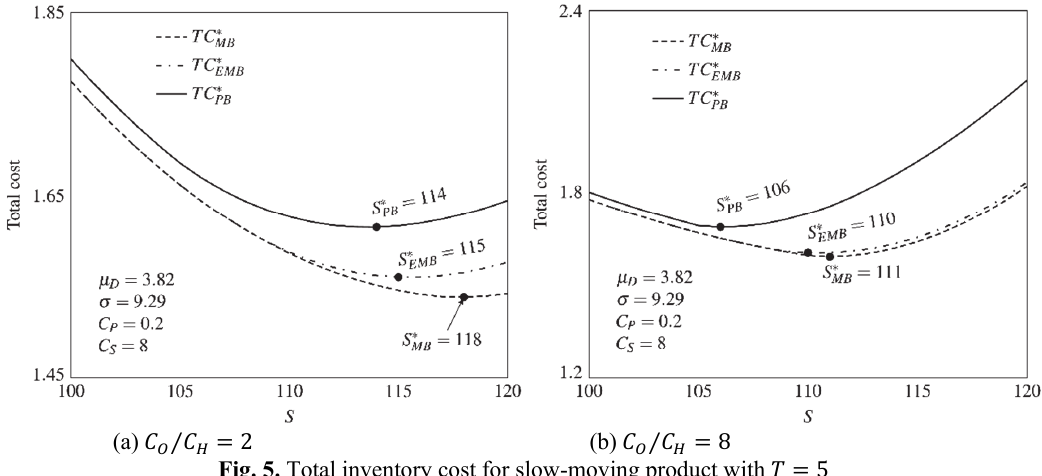
Fig. 5. Total inventory cost for slow-moving product with 𝑇 =